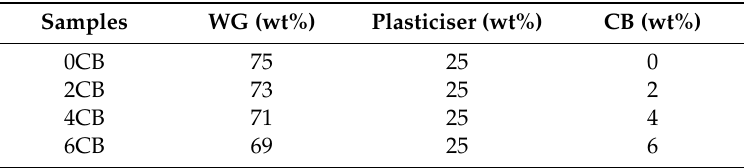
Table 1. The blend ratio of gluten / carbon black (CB)